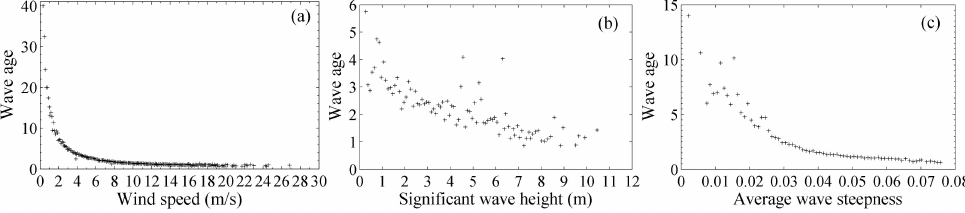
Figure 15. Mean values of wave age over the same wind speed, significant wave height, and average wave steepness.